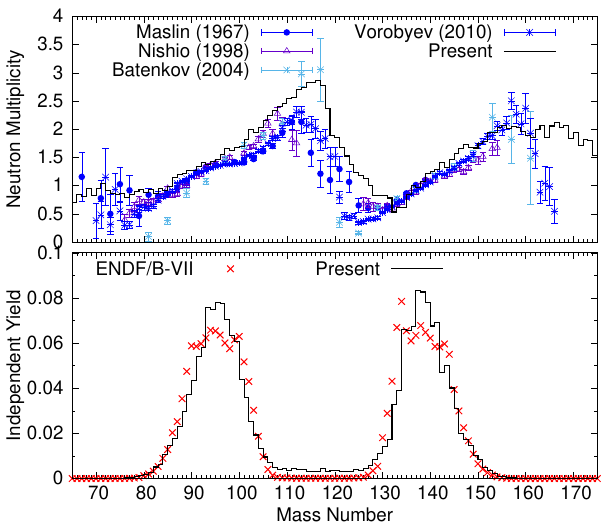
Figure 3. The calculated neuron multiplicity and the indepen- dent FPY as a function of mass